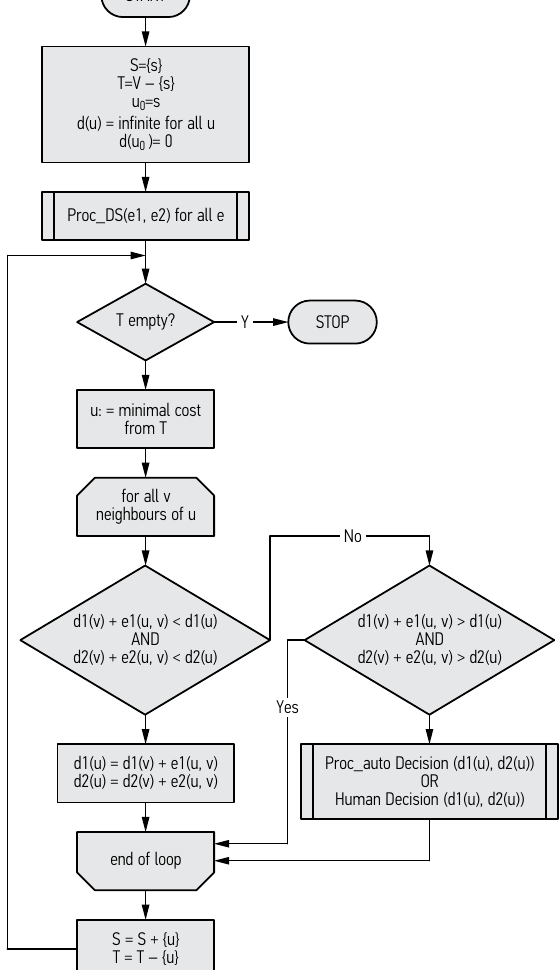
Fig. 2. Route planning algorithm based on uncertain